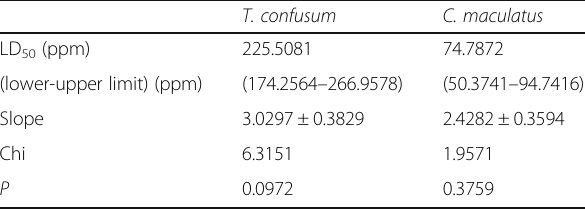
Table 6 LD 50 value of nano zeolite against adults of T. confusum and C.